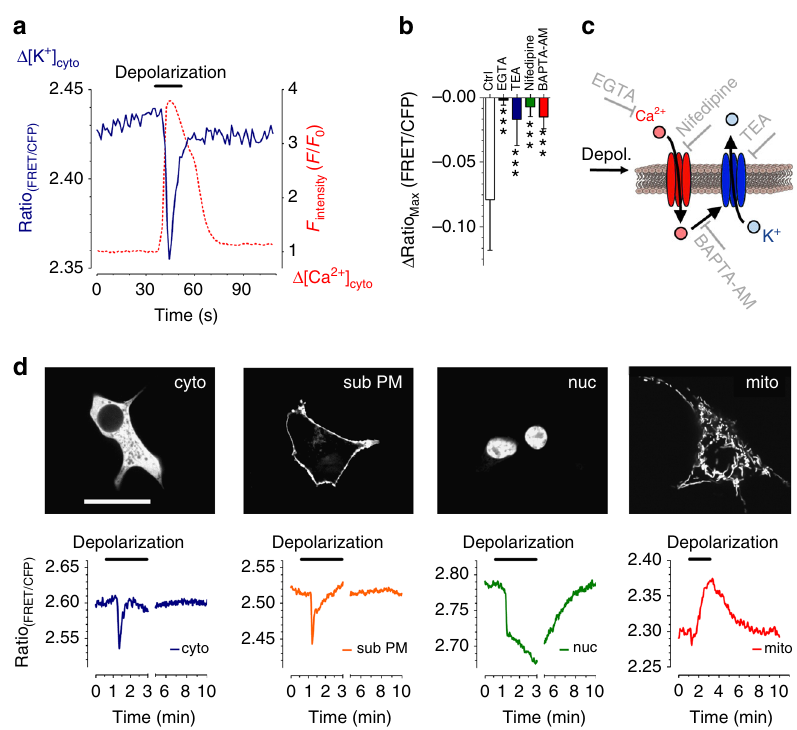
Fig. 6 Real-time imaging of intracellular K + fl uxes. a Representative single cell K + (blue solid line) and Ca 2+ (red dashed line) response of an INS-1 cell expressing lc-LysM GEPII 1.0 and CAR-GECO1 upon cell depolarization using 70 mM KCl ( n = 9 independent measurements/32 cells/32 cells responded as demonstrated). b Columns represent maximal Δ FRET ratio signals ± SD of INS-1 cells expressing cytosolic lc-LysM GEPII 1.0 upon depolarization under control conditions (ctrl, white bar, n = 17/96), in the absence of extracellular Ca 2+ (1 mM EGTA, black bar, n = 7/50), in the presence of 15 mM TEA (blue bar, n = 6/50), in the presence of 100 µ M nifedipine (green bar, n = 6/41), and in cells loaded with BAPTA-AM (red bar, n = 6/53). *** P < 0.0001, one- way ANOVA test with Tukey ’ s Multiple Comparison Test. c Schemes demonstrating the activation of K + ef fl ux via a plasma membrane K + channel by Ca 2+ entry and points of action of pharmacological inhibitors. d Representative confocal images of cytosolic, subplasmalemmal, nuclear and mitochondrially targeted lc-LysM GEPII 1.0 in INS-1 cells (upper images). Scale bar represents 20 µ m. Representative single cell responses of cytosolic ( n = 7/53/53), subplasmalemmal ( n = 7/56/56), nuclear ( n = 7/30/23), and mitochondrially ( n = 7/45/33) targeted lc-LysM GEPII 1.0 upon cell depolarization using 70 mM KCl (lower